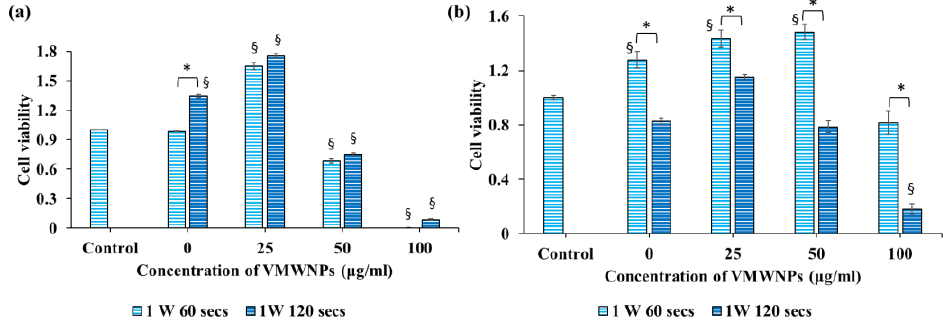
Figure 5. Cell viabilities of ( a ) parental OxS and ( b ) resistant OxR RKO CRC cells upon incubation with different concen- trations of extracellular VMWNPs followed by 800 nm laser irradiation (1 W, 60 s and 1 W, 120 s). § indicates statistical significance compared to the control (0 µ g/mL VMWNPs and no laser) ( p < 0.05). * Indicates statistical significance between 60 and 120 s ( p <